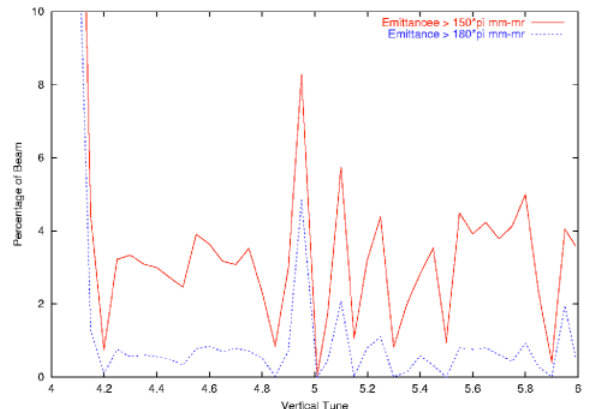
FIG. 17. (Color) Halo production as a function of vertical tune for injection into SNS lattice with n x (cid:1) 5.82